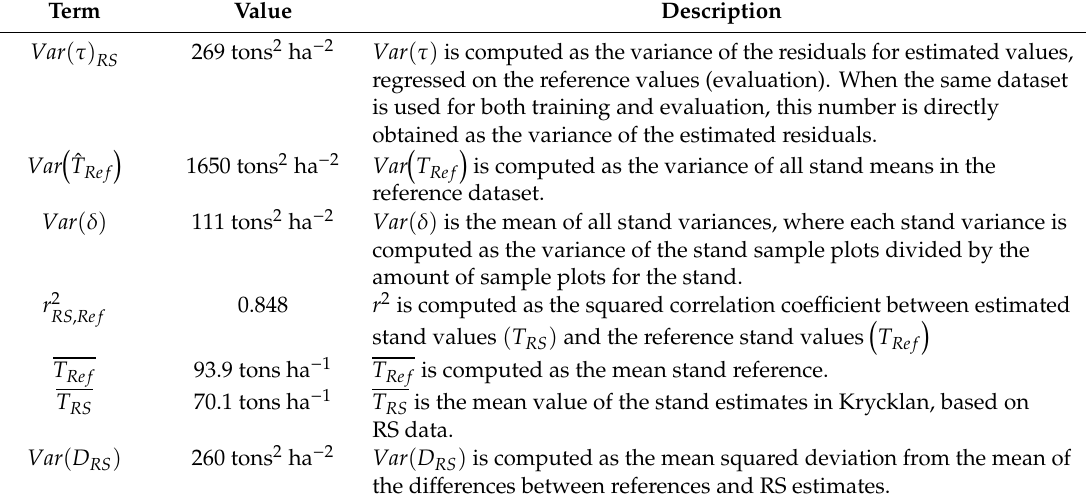
Table A1. Table with values computed for the training dataset, Krycklan, required to compute the proposed error model